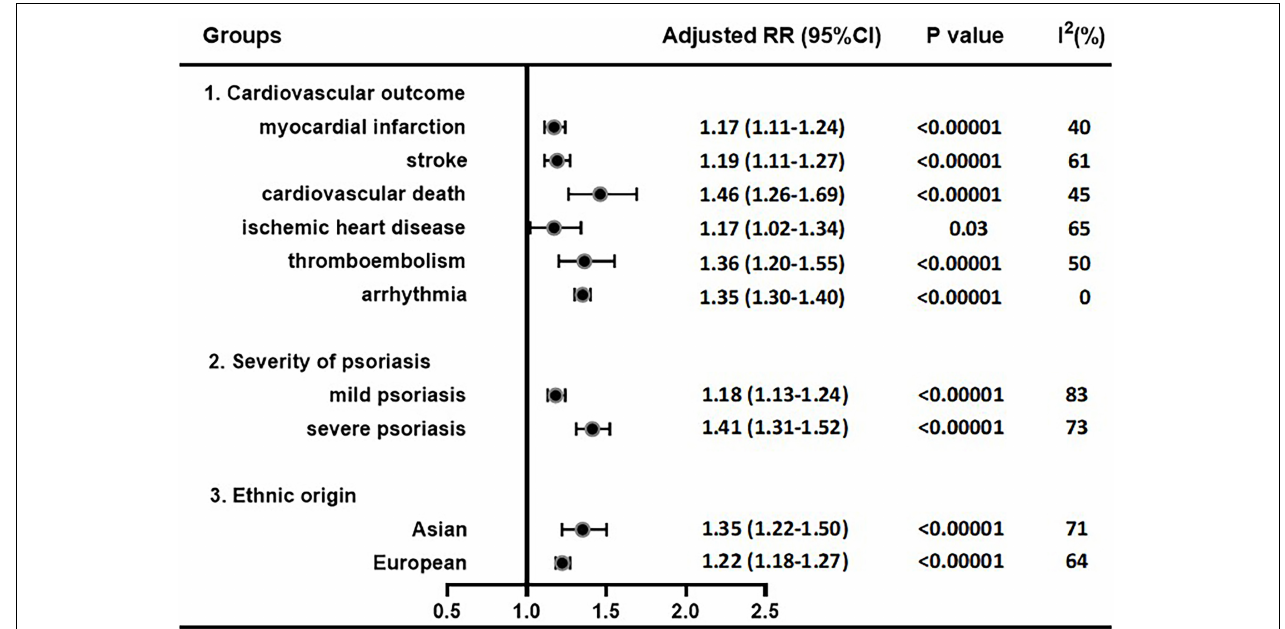
FIGURE 4 | Pooled adjusted RR estimates in each cardiovascular outcome, psoriasis severity and ethnic origin.